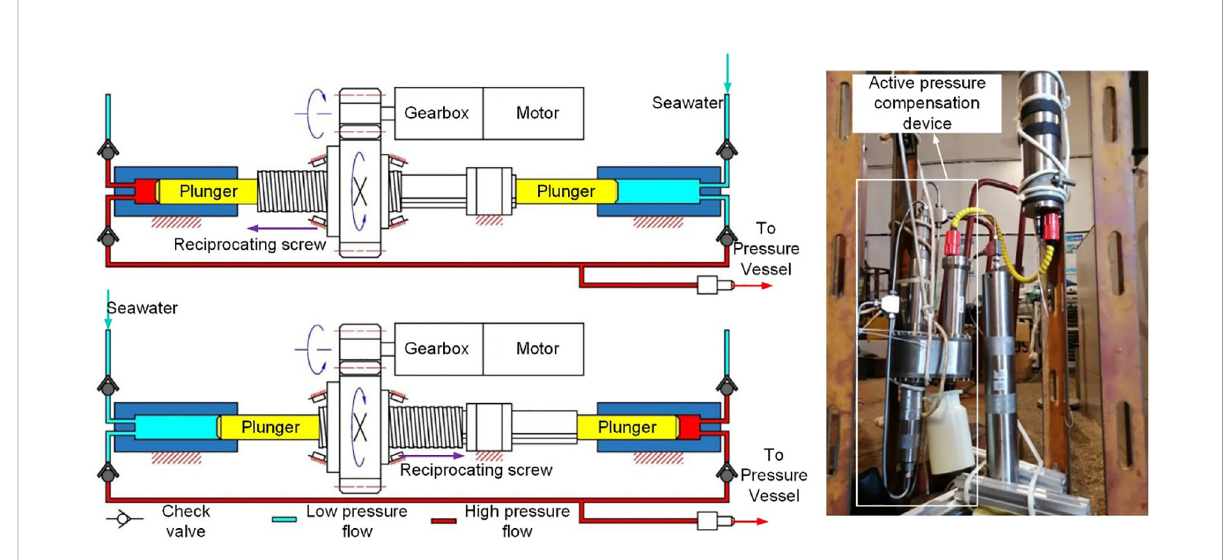
FIGURE 15 Active pressure compensation device (Adapted from Wang,